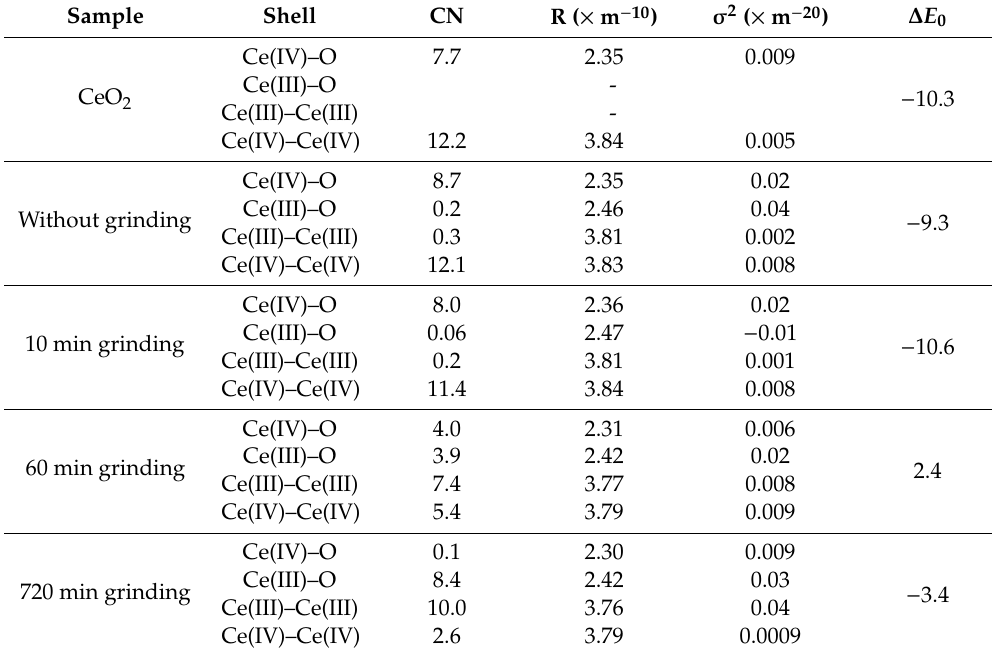
Table 6. Cerium fitting results of radial distribution function for samples with and without grinding, assuming four kinds of cerium shells for tetravalent cerium oxide.